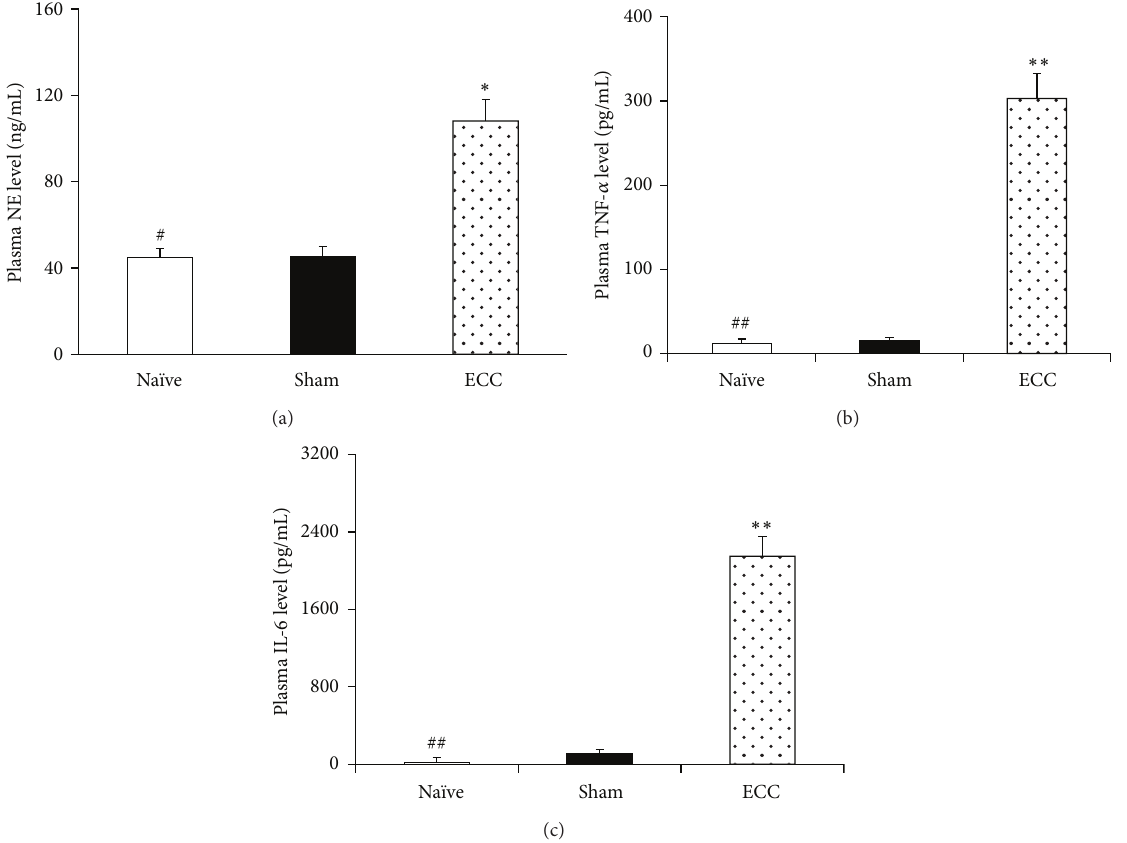
Figure 2: Systemic inflammatory response induced by ECC. Mice in the ECC group were perfused for 30 min in the ECC circuit shown in Figure 1 and then observed for 60min. Mice in the Sham group were observed without ECC for 90 min. Mice in the Na¨ıve group were anesthetized for 90 min, and samples were harvested at once. Systemic inflammatory response was assessed by measuring plasma levels of (a) NE, (b) IL-6, and (c) TNF- 𝛼 at 60 min after the end of ECC. Each treatment group contained 20 animals. ECC, extracorporeal circulation; IL-6, interleukin-6; NE, neutrophil elastase; TNF- 𝛼 , tumor necrosis factor- 𝛼 . ∗ 𝑃 < 0.05 and ∗∗ 𝑃 < 0.01 versus Sham. # 𝑃 < 0.05 and ## 𝑃 < 0.01 versus